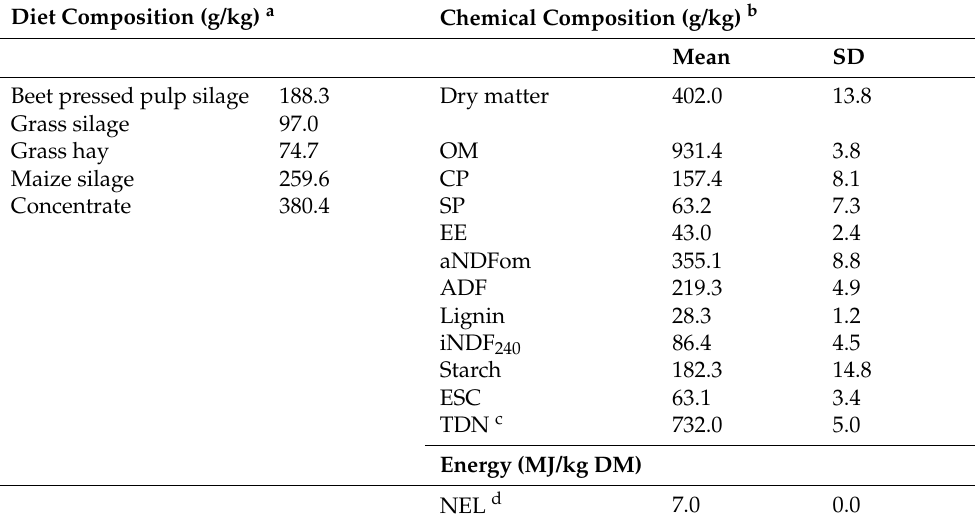
Table 1. Ingredient and chemical composition, and energy content of the total mixed